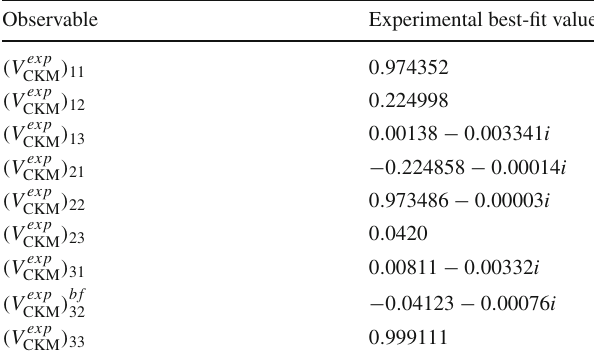
Table 5 The best-fit results for CKM parameters taken from Refs.